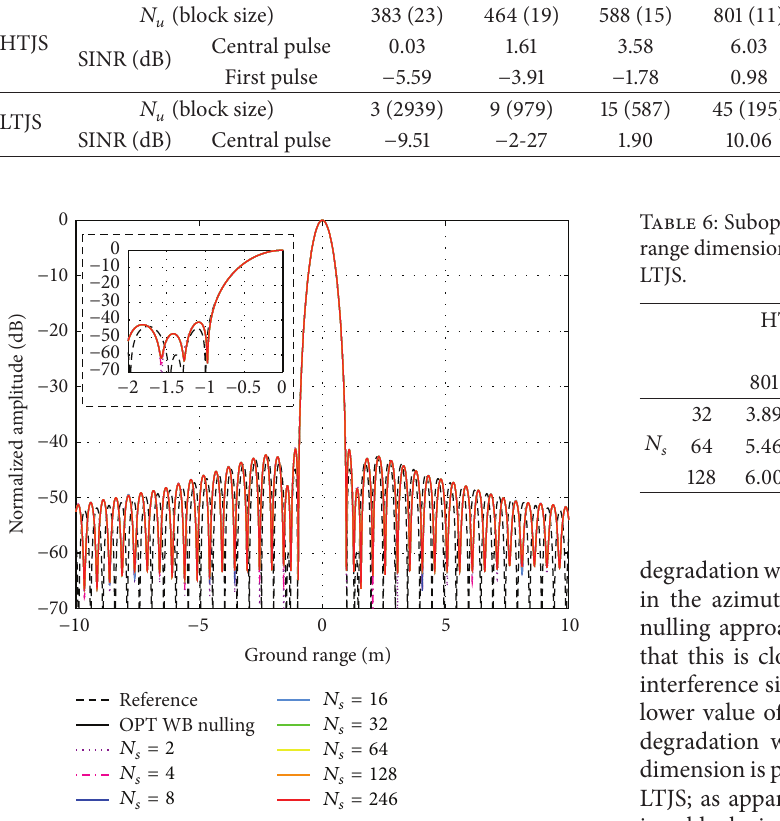
Figure 10: Range pulse response with Hamming tapering (HTJS).